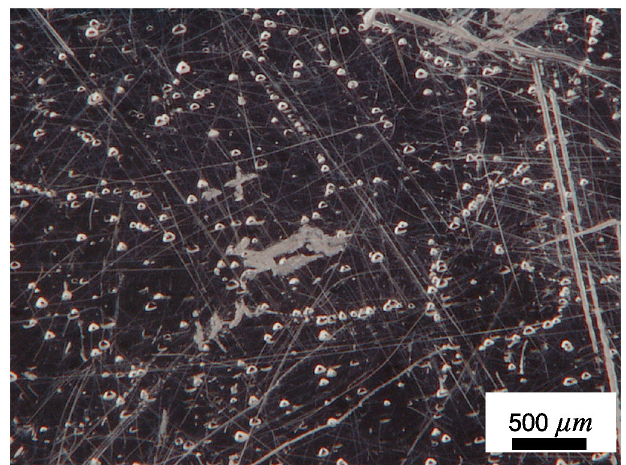
FIG. 10. Optical micrograph of sample 1. The pits’ distribution has a ‘‘network’’ pattern that might reveal subgrain boundaries.